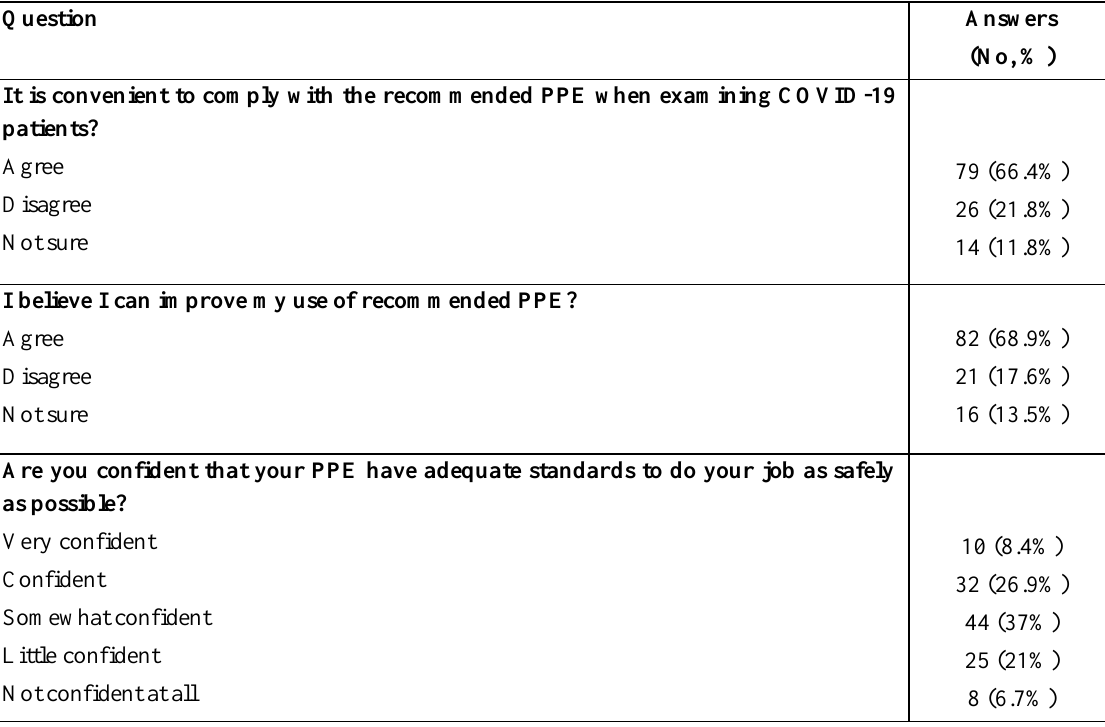
Table 4. Personal protective equipment attitude among the